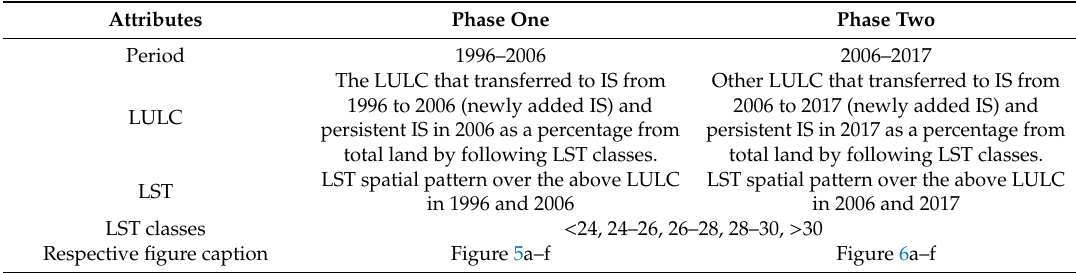
Table 7. Detailed attributes of the two